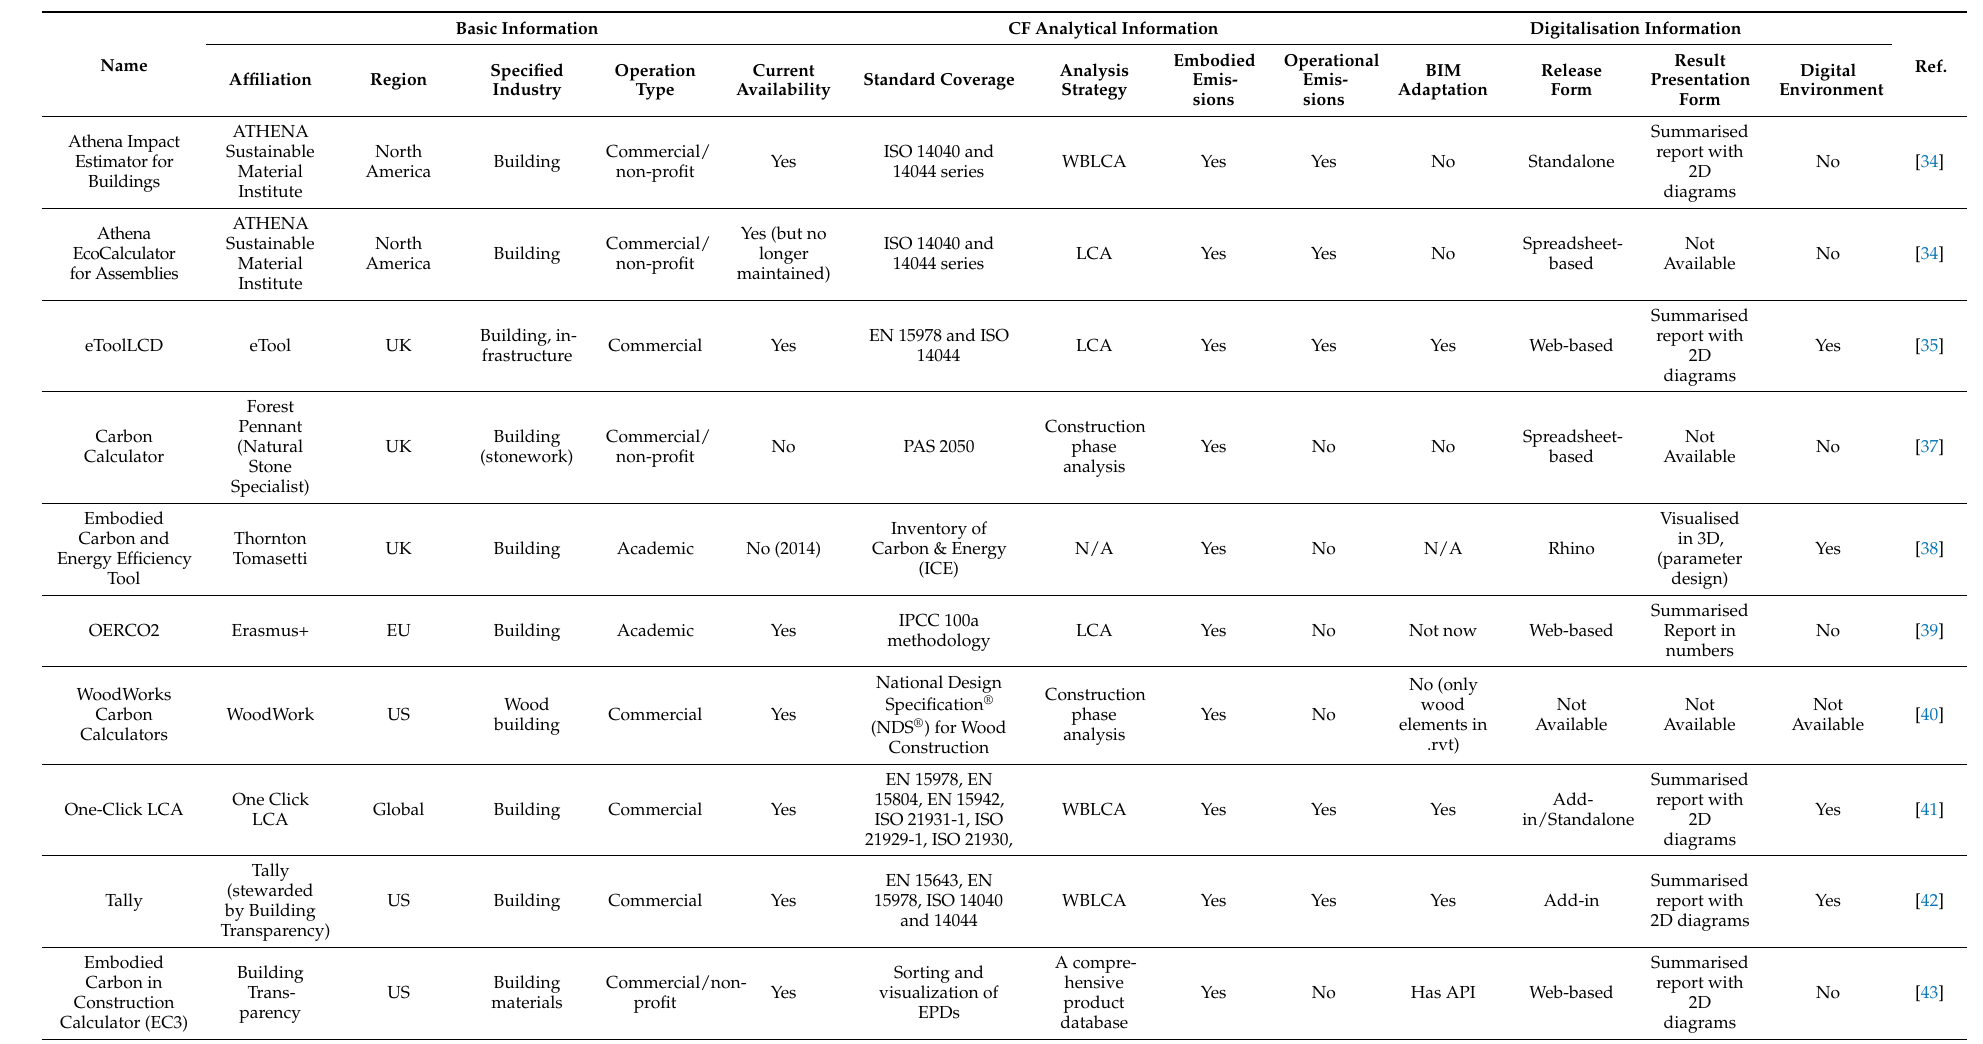
Table 3. Summary of digital tools in building